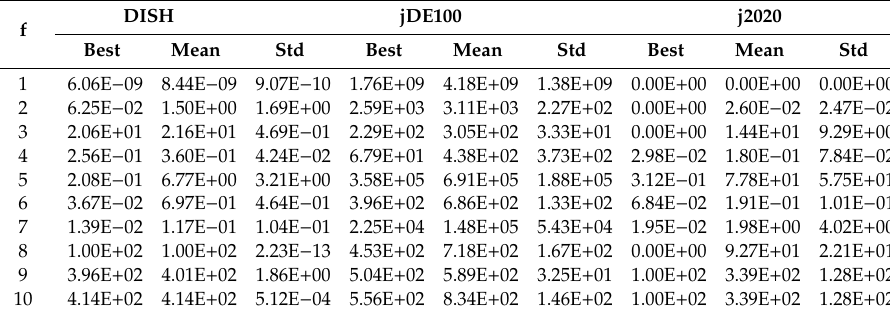
Table 22. DISH and jDE100 on CEC2020 in 20 D .